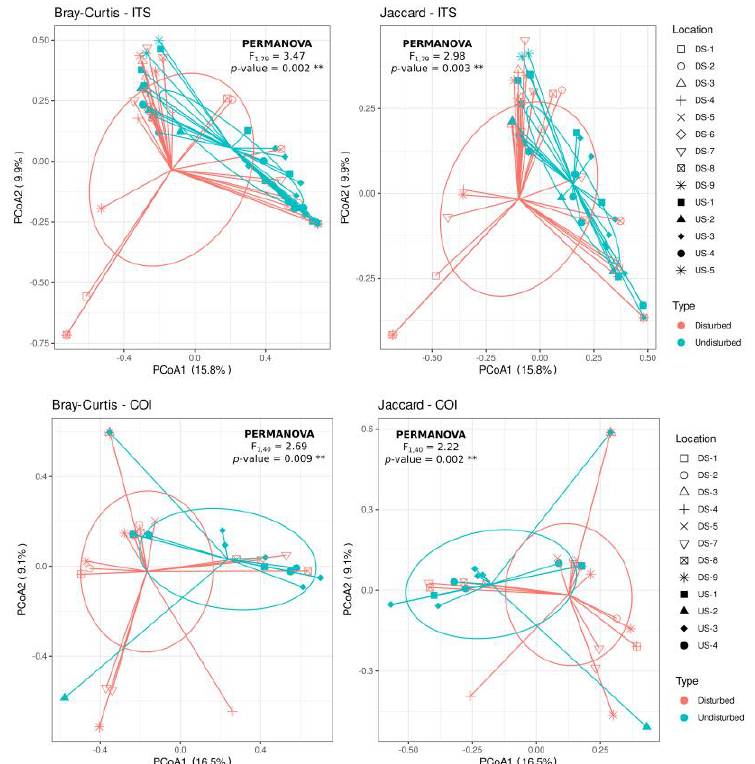
Figure 3. Principal coordinates analysis (PCoA) of Bray–Curtis and Jaccard distance matrices from Phytophthora spp. and Nothophytophthora spp. community composition data obtained using COI and ITS markers. PCoA were plotted in the form of a spider diagram with “legs” joining samples that belong to the same cluster (centroid). Shapes on the figure legend correspond to the locations and colors to the sites (“disturbed” and “undisturbed”) sampled.